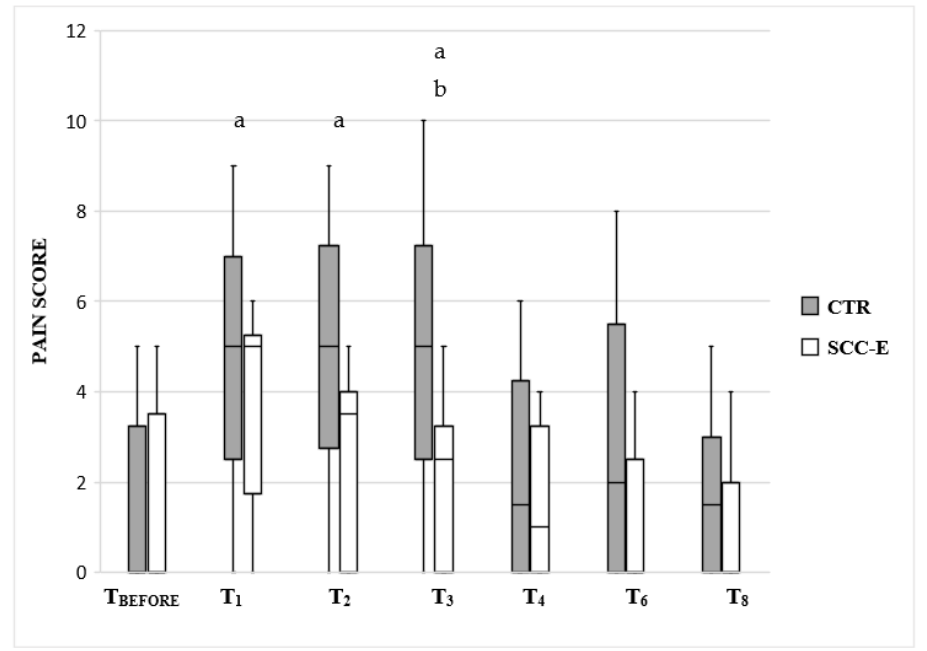
Figure 4. UNESP-Botucatu-MCPS pain scale recorded for 8 h after surgery in cats undergoing ovariohysterectomy with (SCC-E group) or without (CTR group) sacrococcygeal epidural ( n = 10 in each group). Times: T BEFORE , prior to premedication, T 1 , T 2 , T 3 , T 4 , T 6 , and T 8 = 1 h, 2 h, 3 h, 4 h, 6 h, and 8 h after surgery completion, respectively. The horizontal line inside the boxes denotes the median value, while the upper and lower whisker bounds denote the maximum and minimum values. The boxes show the interquartile ranges. a Significant differences compared with T BEFORE ( p = 0.0045, 0.0004, and 0.0034 for T 1 , T 2 , and T 3 , respectively). b Significantly superior compared to the SCC-E group ( p = 0.027).